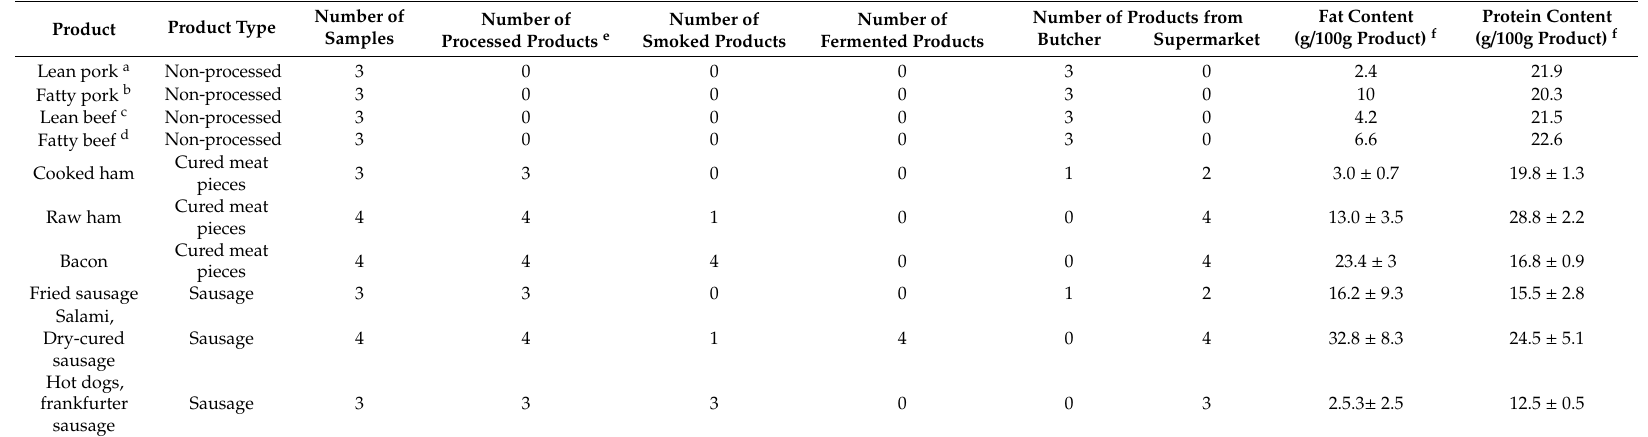
Table 1. Characteristics of meat products purchased in local supermarkets and butcher shops and digested in vitro in